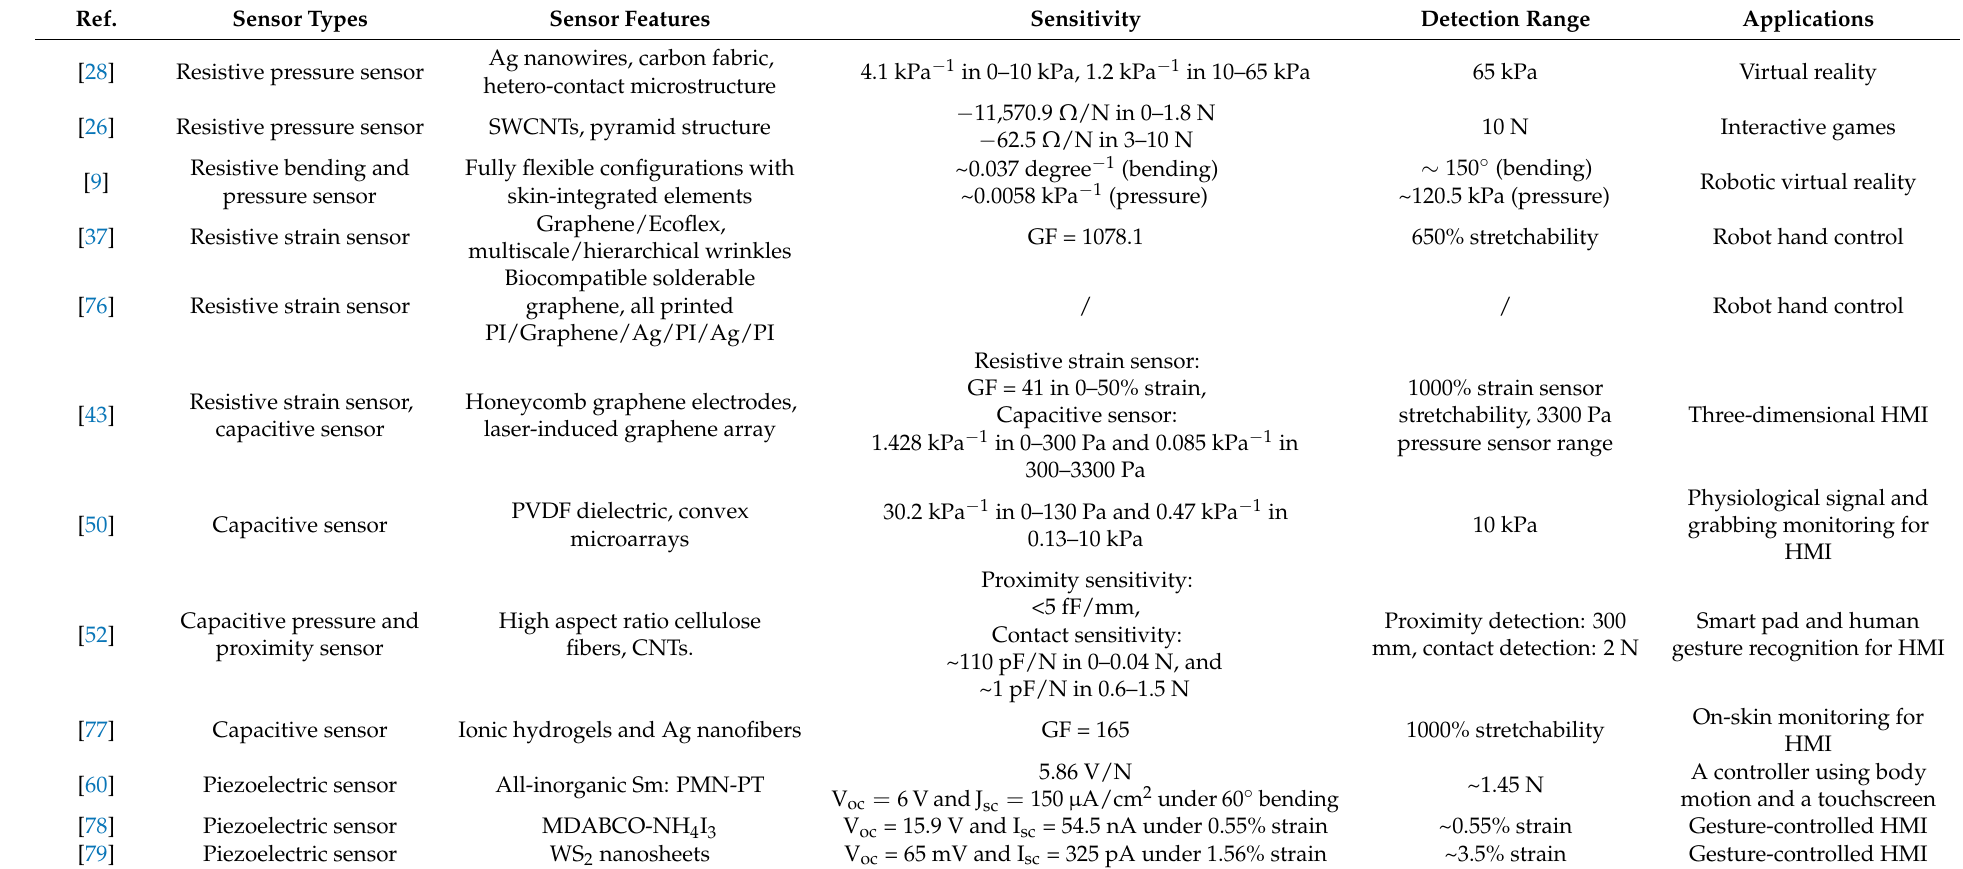
Table 1. Summary of typical tactile and force sensors for human–machine interaction.